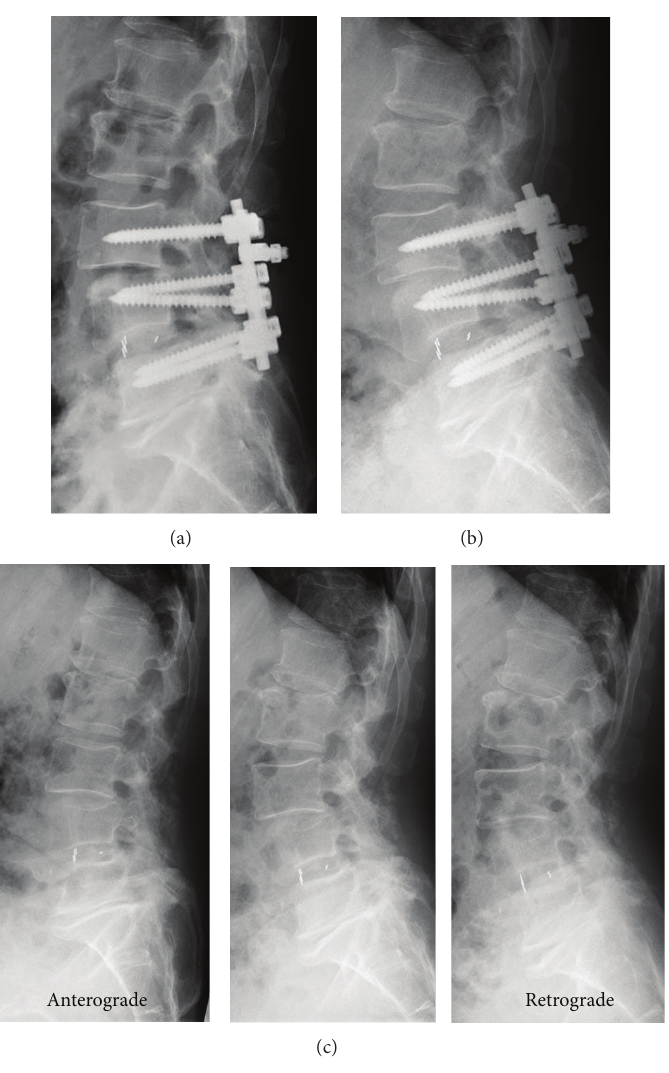
Figure 3: Plain lumbar radiographs taken just after the fusion operation (a), 1 year after the operation (b), and 2 years after the operation (c). There was slight retrolisthesis and decreased posterior disc height on L2/3 on 1-year (b) and 2-year follow-up (c), but with no definite instability (c).